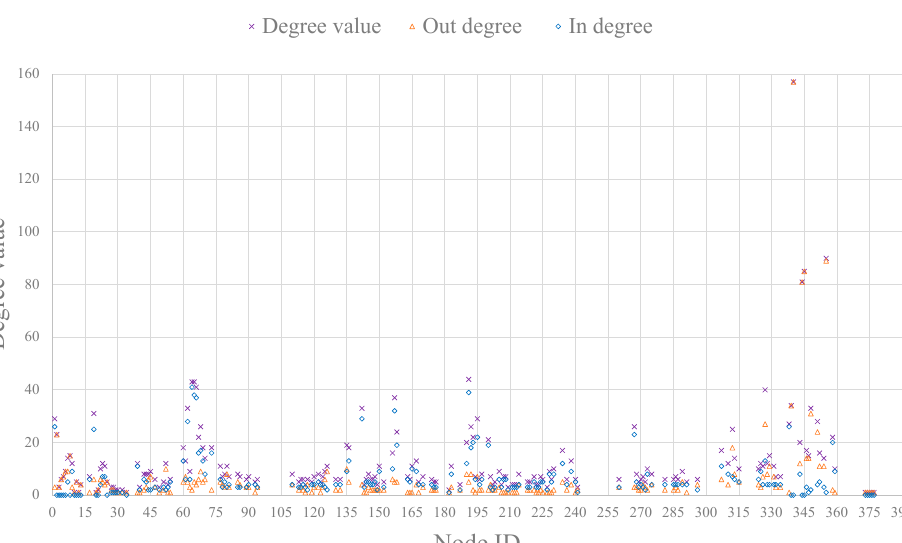
Figure 4. Node degree in the ENRRTP.